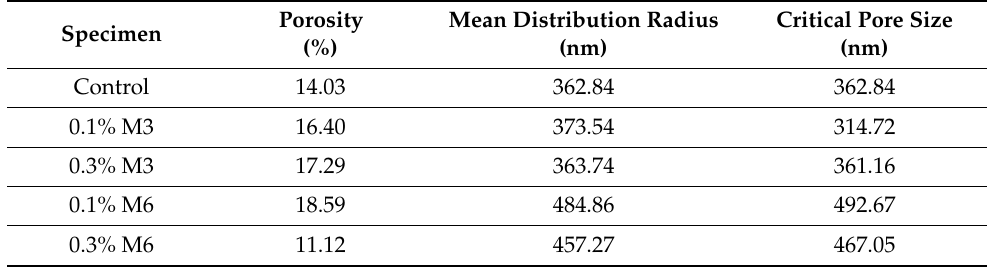
Table 6. Pore characteristics obtained from mercury intrusion porosimetry for the bulk material ( n = 1).